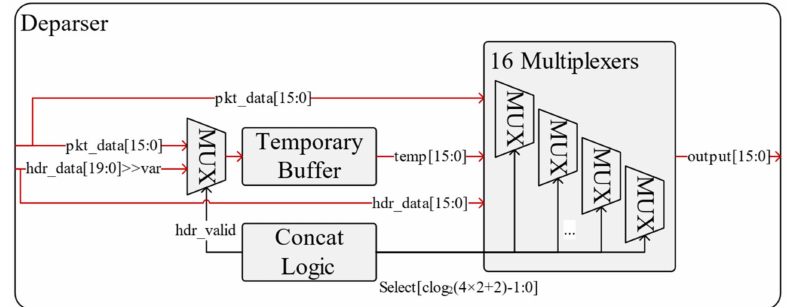
Figure 4. Concatenation design in deparser. For brevity, indexes here refer to bytes instead of bit, except for the Select signal.